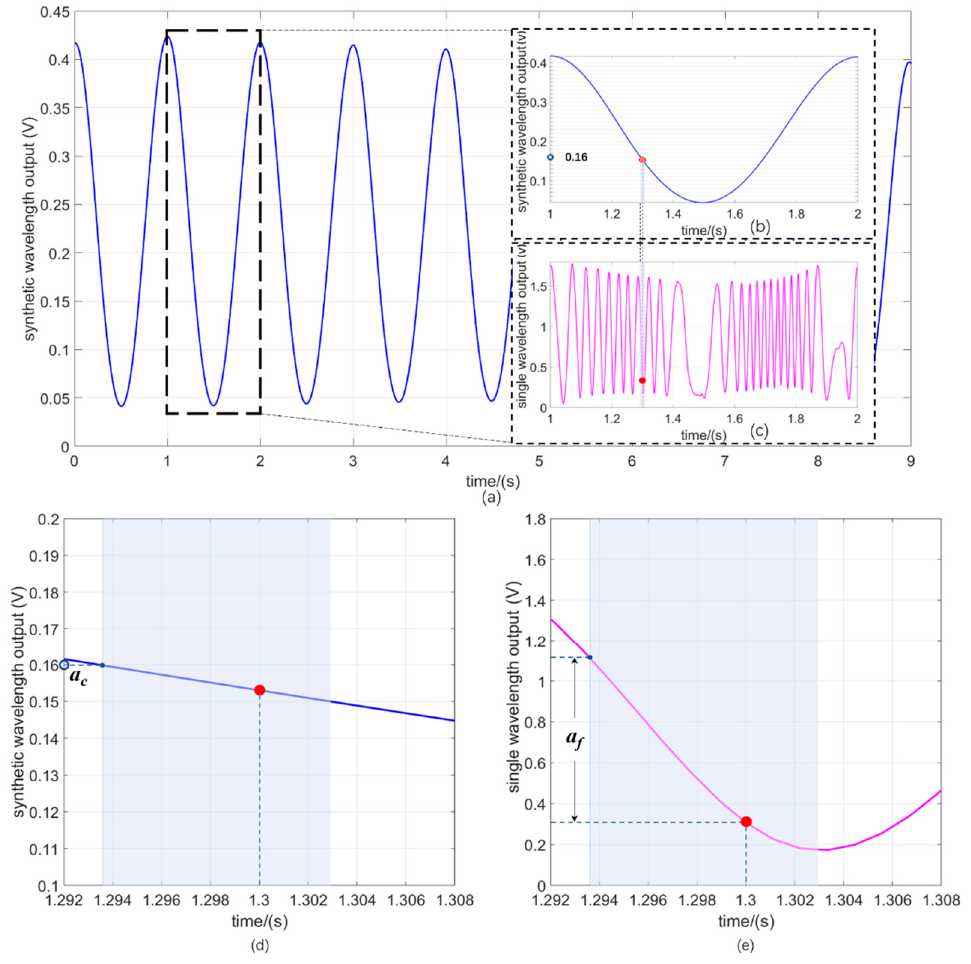
Figure 5. Measurement results of ( a ) synthetic wavelength output versus sampling time in 9 s; ( b ) synthetic wavelength output versus sampling time from 1 to 2 s along with calibrated intervals; ( c ) corresponding single wavelength output versus sampling time from 1 to 2 s. ( d ) Enlarged view of synthetic wave output versus sampling time from 1.292 to 1.308 s; pink area represents an interval where the specific time 1.3 s is located. ( e ) Enlarged view of single wave output versus sampling time from 1.292 to 1.308 s.